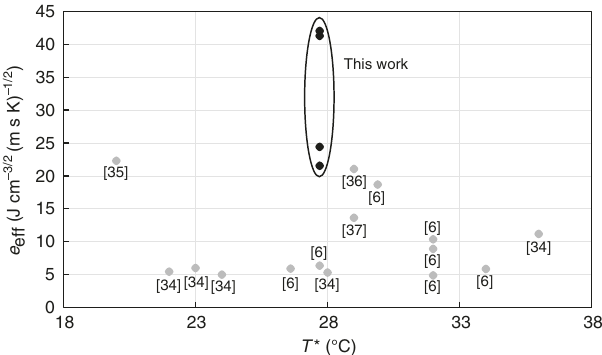
Fig. 2 Master plot for effective thermal effusivity. Master plot of effective thermal effusivity for phase change materials measured in the literature and this work (references in brackets 6, 34 – 37 ). Results are con fi ned to isotropic and ambient phase change materials (transition temperature T * occurring between 20 and 40 °C), for which volume-speci fi c latent heat and thermal conductivity are directly or indirectly reported. The four data points enclosed in the ellipse refer to this work for graphene-modi fi ed and pristine Ni and Cu foams infused with